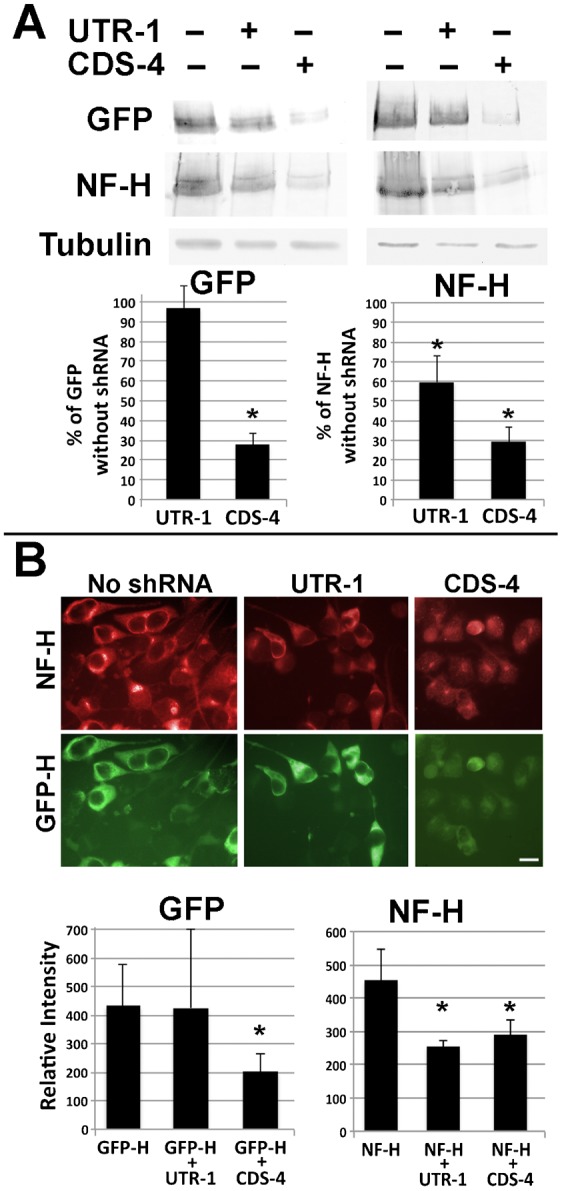
Co-transfection with GFP-H and shRNA.(A) Replicate sets nitrocellulose replicas of homogenates of cells transfected with GFP-H with and without co-transfection with UTR-1 or CDS-4 and probed with anti-GFP, anti-NF-H antibody and anti-tubulin antibody DM1A (as a loading control) as indicated. The accompanying graphs present densitometric analyses of these replicas. Co-transfection with UTR-1 did not reduce GFP-H levels but reduced endogenous NF-H as evidenced by a reduction in total NF-H immunoreactivity. Co-transfection with CDS-4 reduced both GFP-H and total NF-H immunoreactivity (asterisks indicate p<0.01 versus cultures not receiving shRNA; ANOVA with Fischer's post-hoc analyses). (B) Representative fluorescent images of cells transfected as in panel A and reacted with anti-NF-H followed by Texas-Red conjugated secondary antibody. Bar: 25 µm. The accompanying graphs present densitometric analyses of 20–100 cells under each condition from multiple fields. As in immunoblot analyses, co-transfection with UTR-1 did not reduce GFP-H levels but reduced total NF-H immunoreactivity. Co-transfection with CDS-4 reduced both GFP-H and total NF-H immunoreactivity (asterisks indicate p<0.005 versus cultures not receiving shRNA; ANOVA with Fischer's post-hoc analyses).